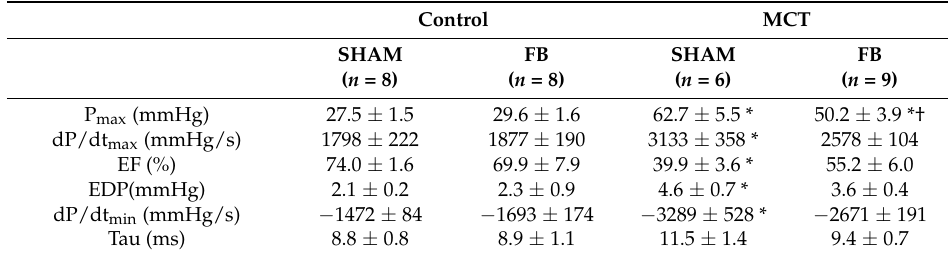
Table 2. Xanthohumol-fortified beer (FB) effect on right ventricular hemodynamic evaluation of healthy controls and monocrotaline (MCT)-induced PAH animals.